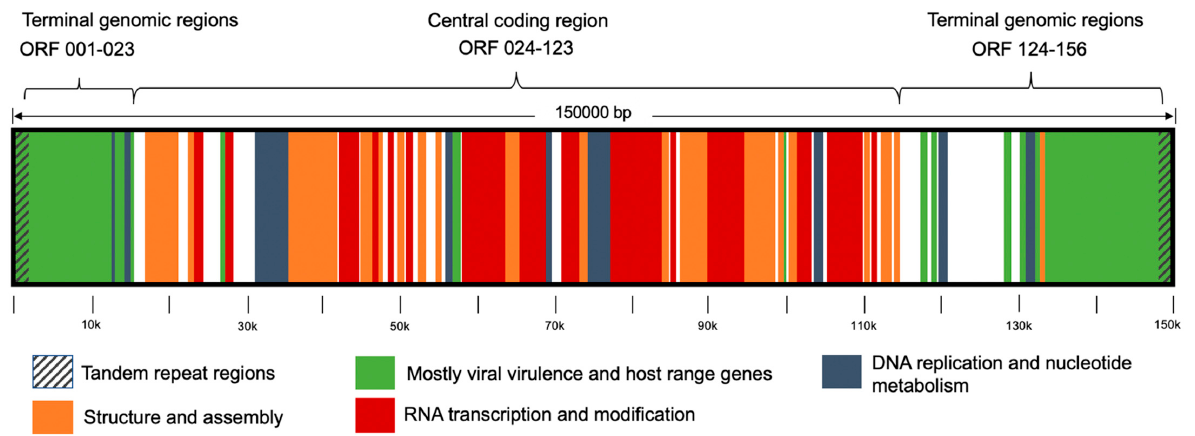
Figure 3. Capripox virus genome organisation, modified from Tulman et al., 2001. In order to detect genome regions that distinguish the virus species, multiple libraries of 15, 10 and 5 kbp long sequences taken from LSDV genome were established. For com- parison, pairwise identities of the BLAST were examined. No significant divergences be- tween the pairwise identities of LSDV and those of GPV and SPV were found. Therefore, none of the regions showed evidence of further genetic difference suitable for virus dif- ferentiation.